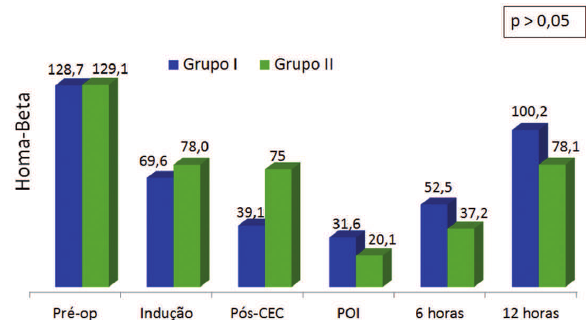
Fig. 5 - Comparação dos resultados dos valores medianos do índice de Homa-Beta para os pacientes dos grupos I e II, nos diversos períodos de análise. Pré-op = Pré-operatório, CEC = Circulação Extracorpórea, POI